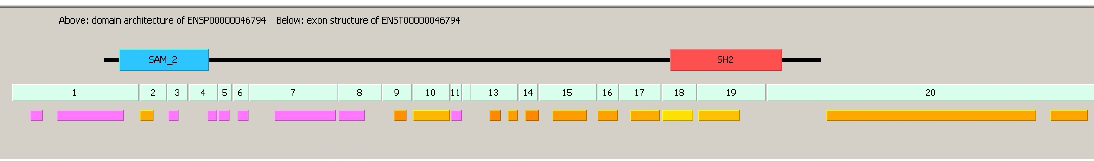
Figure 6: Graphical information on the LCP2 protein with integrated expression data. At the top, the domain architecture of the protein is depicted. In the center, the underlying exon structure is displayed, including the 3' and 5' UTRs of the transcript sequence. At the bottom, the probe- sets annotated to the exons are shown. Probesets are colored according to their presence (color gradient from yellow to red) and absence